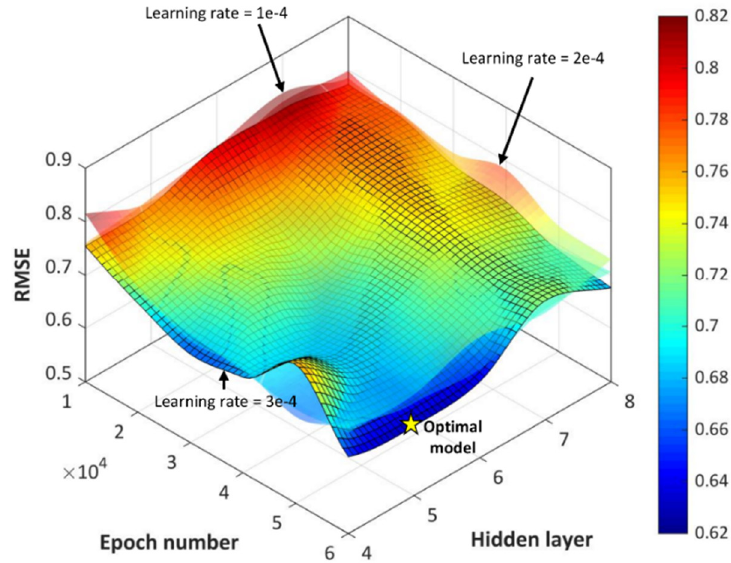
Figure 5. Parametric optimization of KO model using deep learning